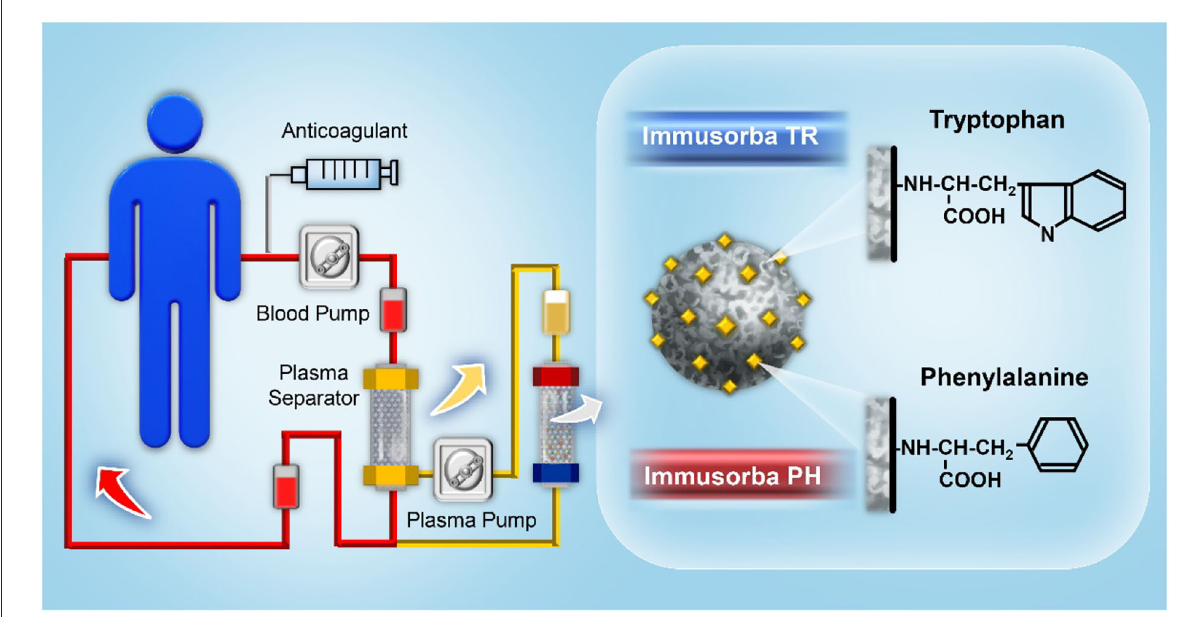
FIGURE2 A schematic illustration of immunoadsorption using Immusorba TR and Immusorba PH.